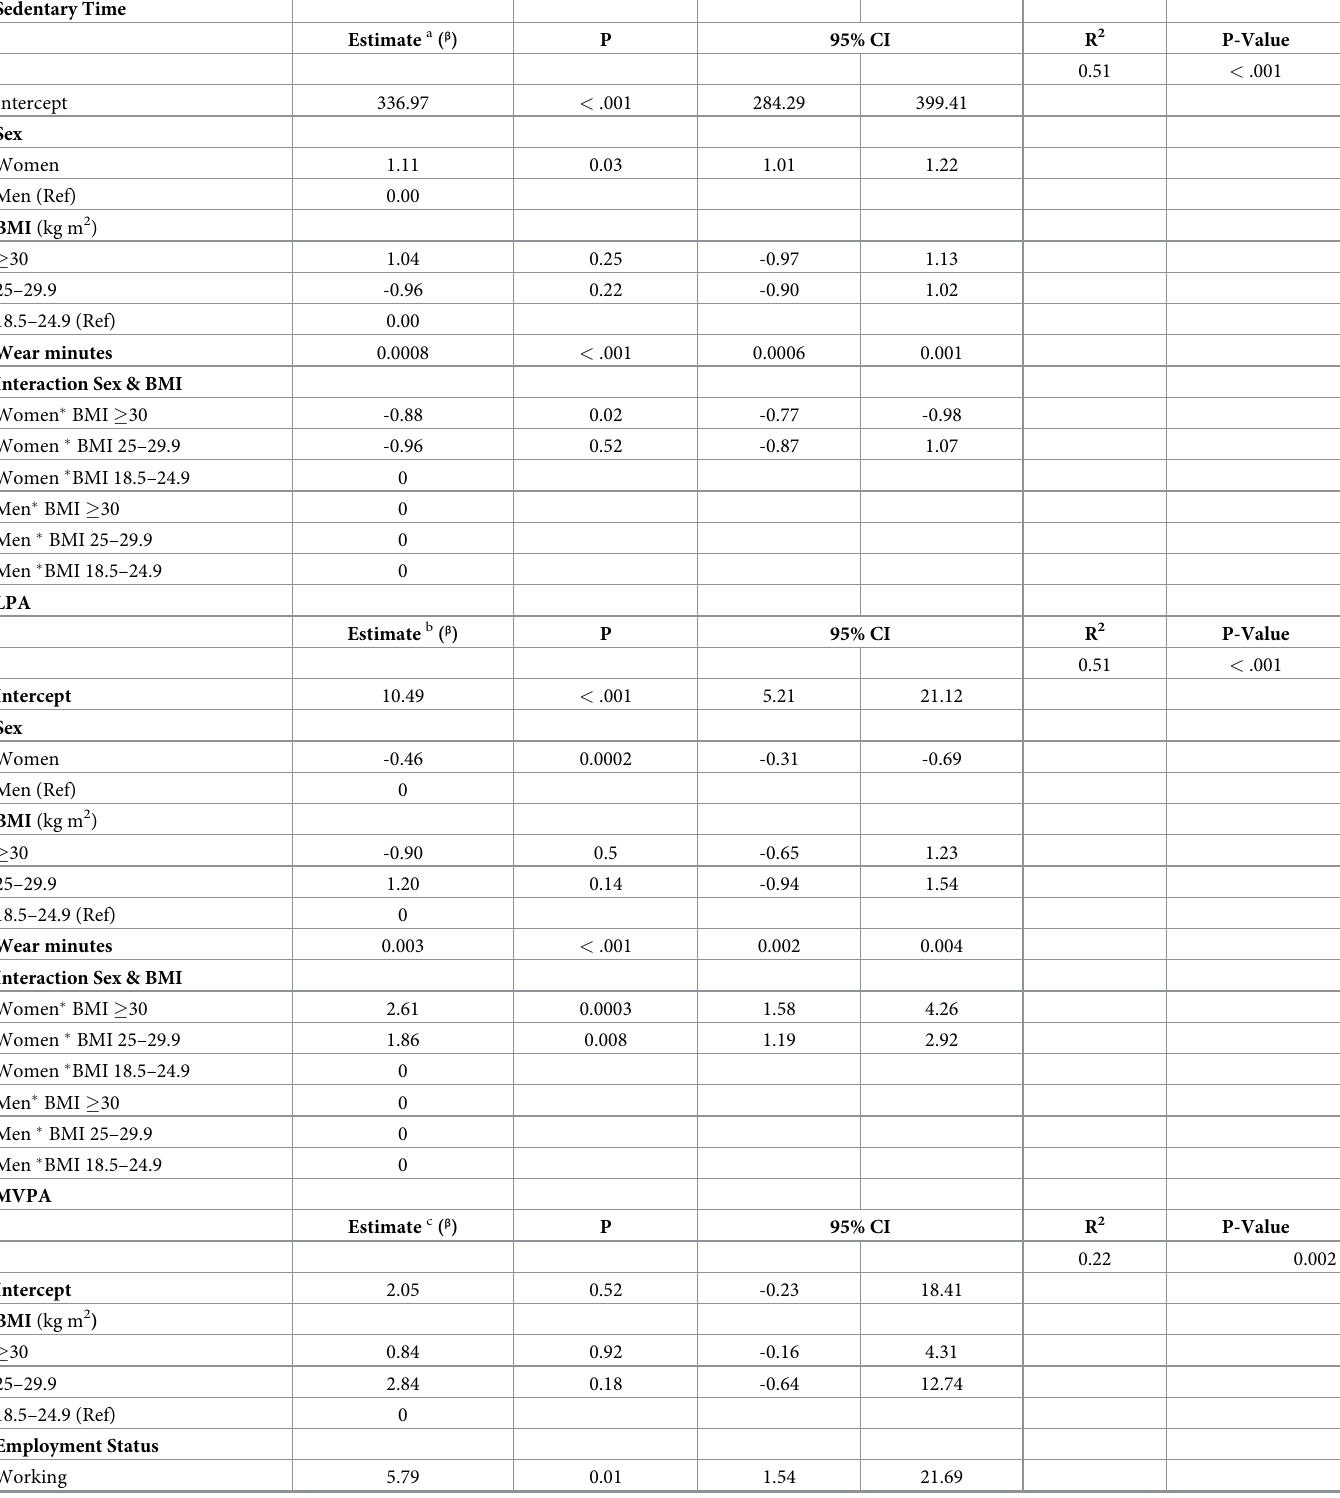
Table 3. Multivariable linear regression models for sedentary time, LPA and